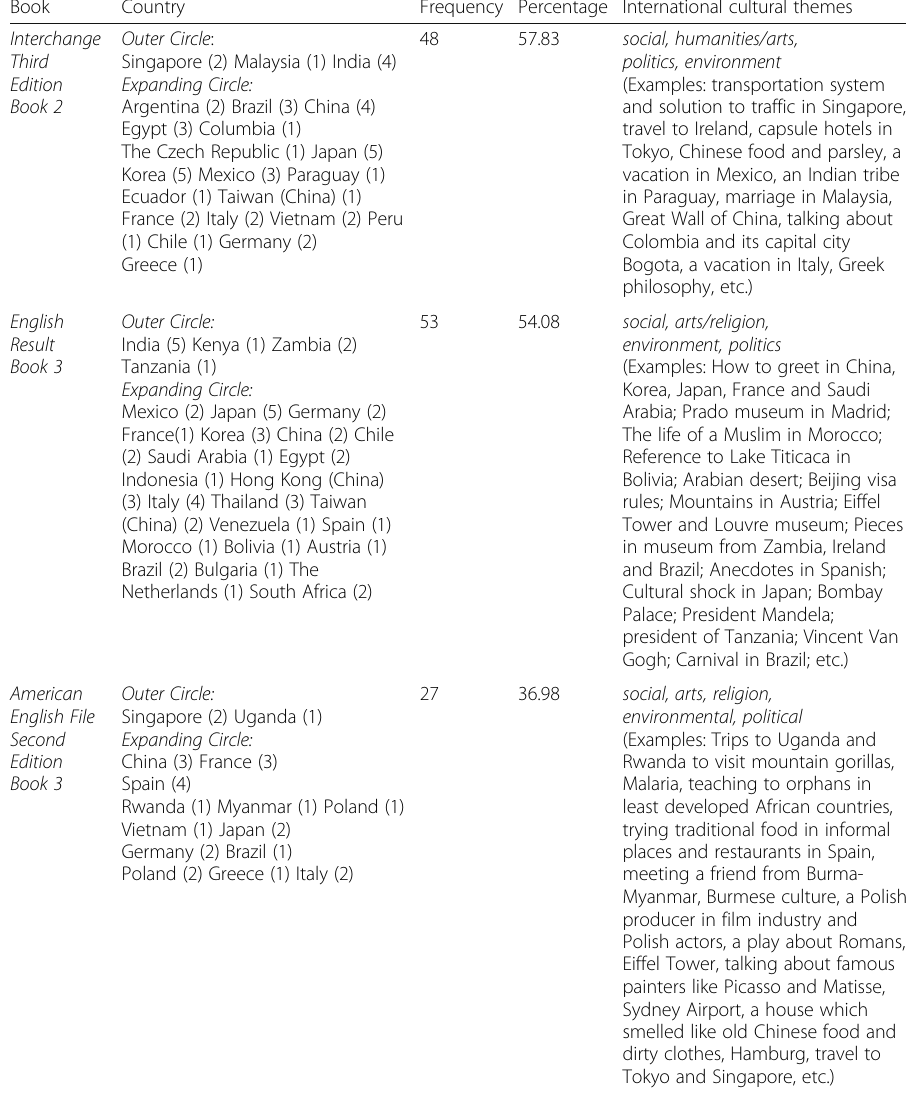
Table 2 Frequency of references to outer and expanding circle countries